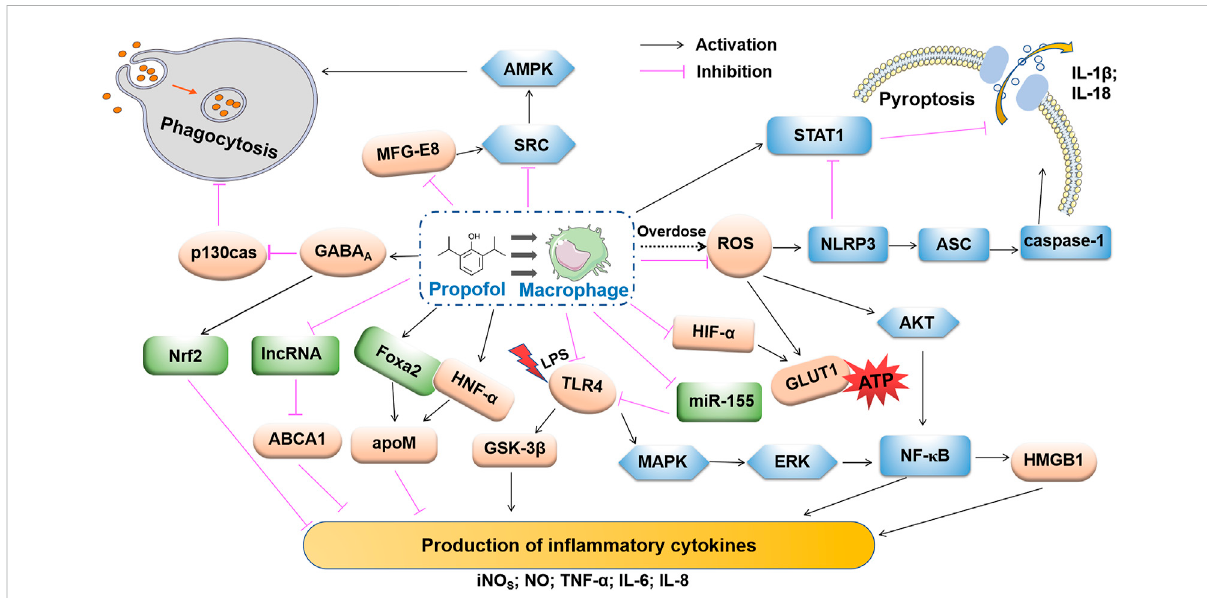
FIGURE 2 Propofol regulation in macrophage phagocytosis, pyroptosis and production of in fl ammatory cytokines. High-dose propofol activates pro- caspase-1 viaNLRP3 andAIM2 in fl ammasomesviathein fl ammasome adaptor ASC.Propofol-induced mitochondrialROS may trigger theactivation of NLRP3. The clinical dose of propofol inhibits pyroptosis by activating STRT1. Propofol inhibits pressure effects on macrophage phagocytosis by activating the GABAA receptor and inhibiting p130cas. Propofol reduces microglial production of MFG-E8 and inhibits cellular phagocytosis usingtheMFG-E8-dependent SRC-AMPK pathway.Propofolinhibits theROS-mediated AKTand NF- κ Bpathways. Propofol also inhibits MAPK/ERK, the upstream regulator of NF- κ B. Dissociated NK- κ B is transferred to the cytoplasm and further induces the release of HMGB1, which inhibits